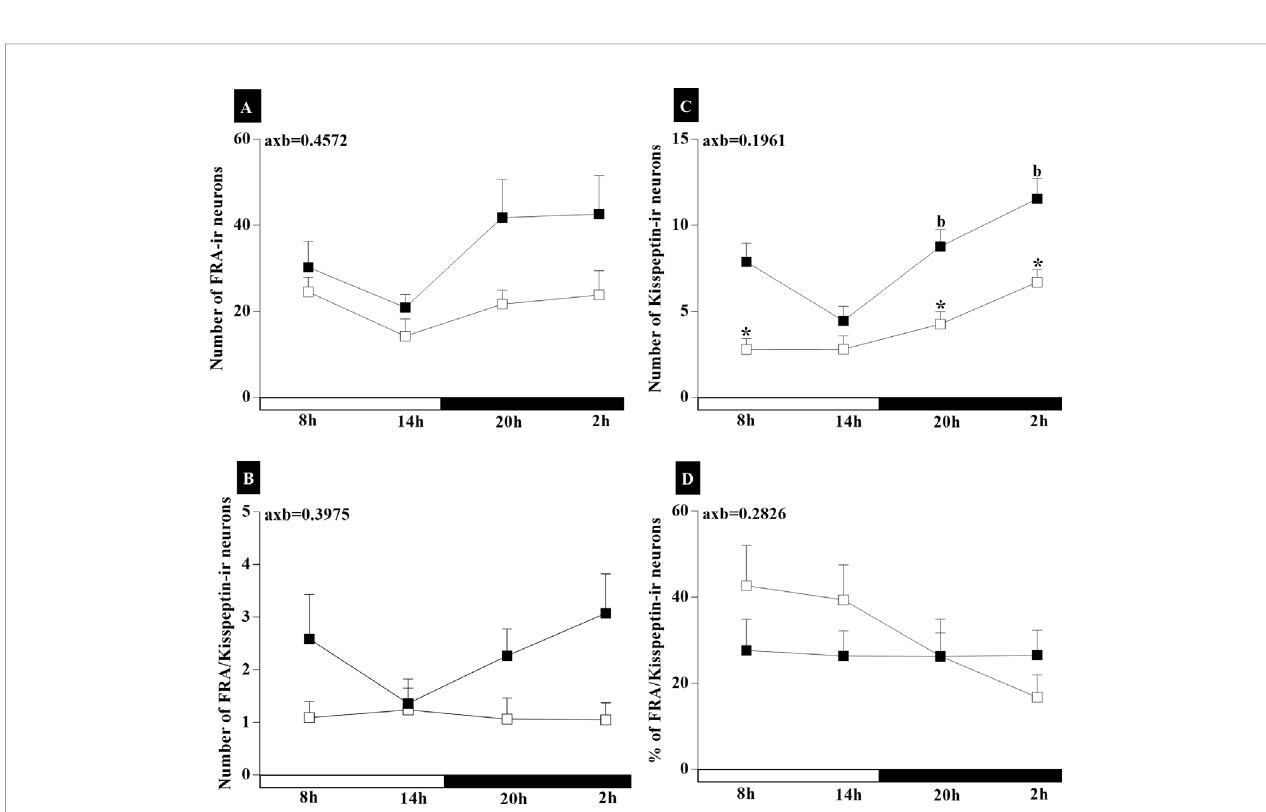
FIGURE 3 | Graphical representation of higher Kisspeptin neuronal activity observed in IC group rats with irregular cycle (IC) in persistent diestrus ( □ ) compared to adult rats with regular estrous cycle (RC) on diestrus day ( ■ ). The mean ± SEM number of FRA-ir neurons (A) , Kiss-ir neurons (B) , FRA/Kiss-ir neurons (C) , and % FRA/Kiss-ir neurons (D) are shown on the graph. * p < 0.05 vs. RC at the same time interval; b vs.14:00; axb = interaction of age and